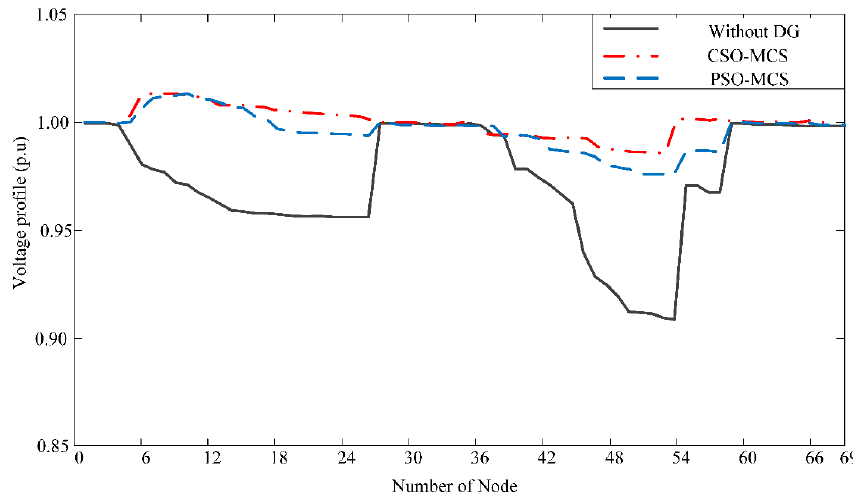
Figure 6. Voltage profile contrast (Case 2).